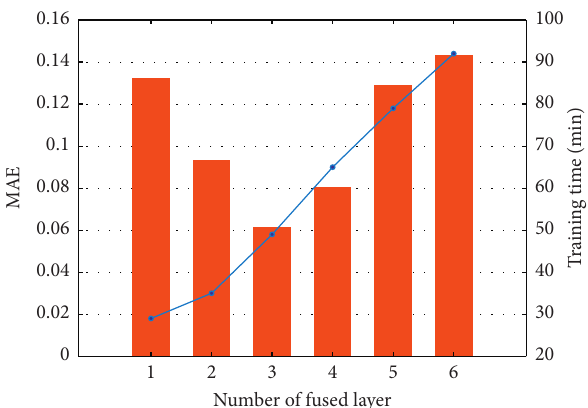
Figure 9: Effect of the number of fused dilated convolution layer on the